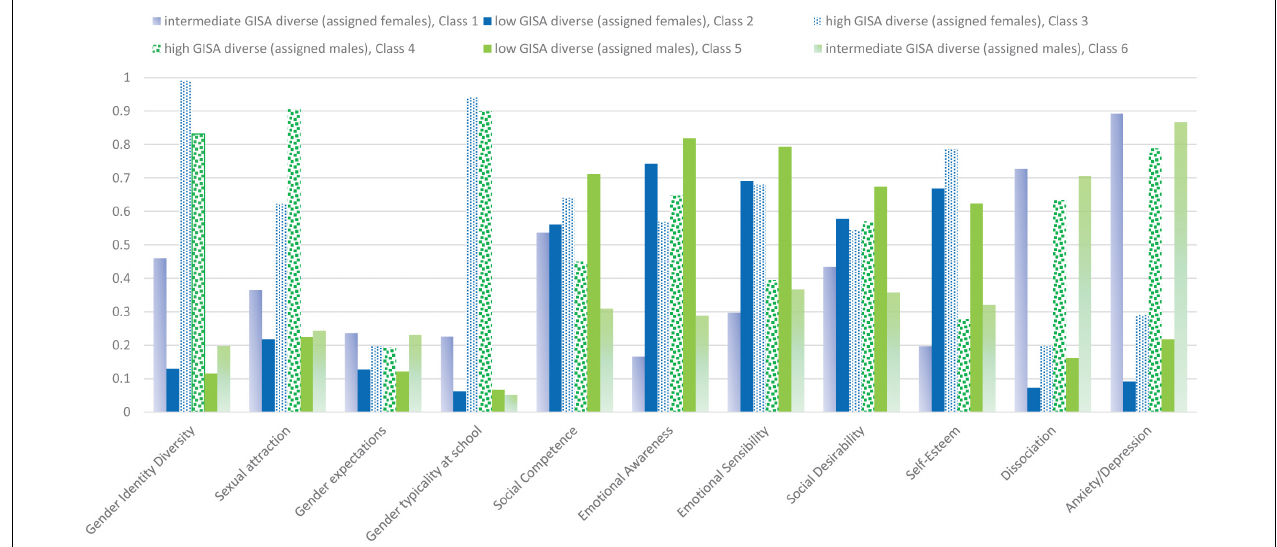
FIGURE 1 | Diagrammatic representation of the identified six gender patterns (three classes solution) by 11 indicators examined by latent class analysis, percentage of category 2 “high level of the specific indicator” in the respective class.